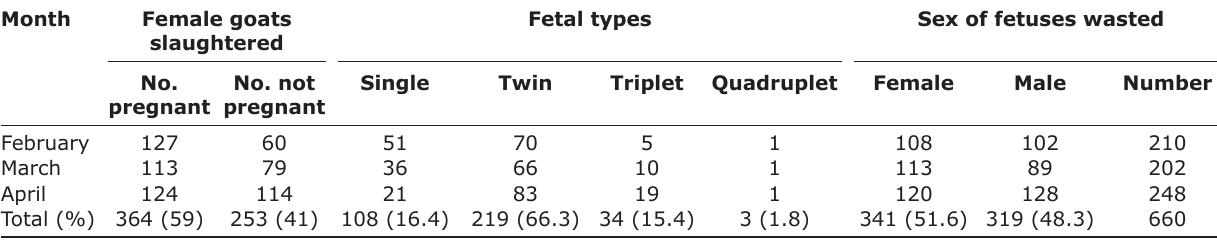
Fetal types Sex of fetuses wasted